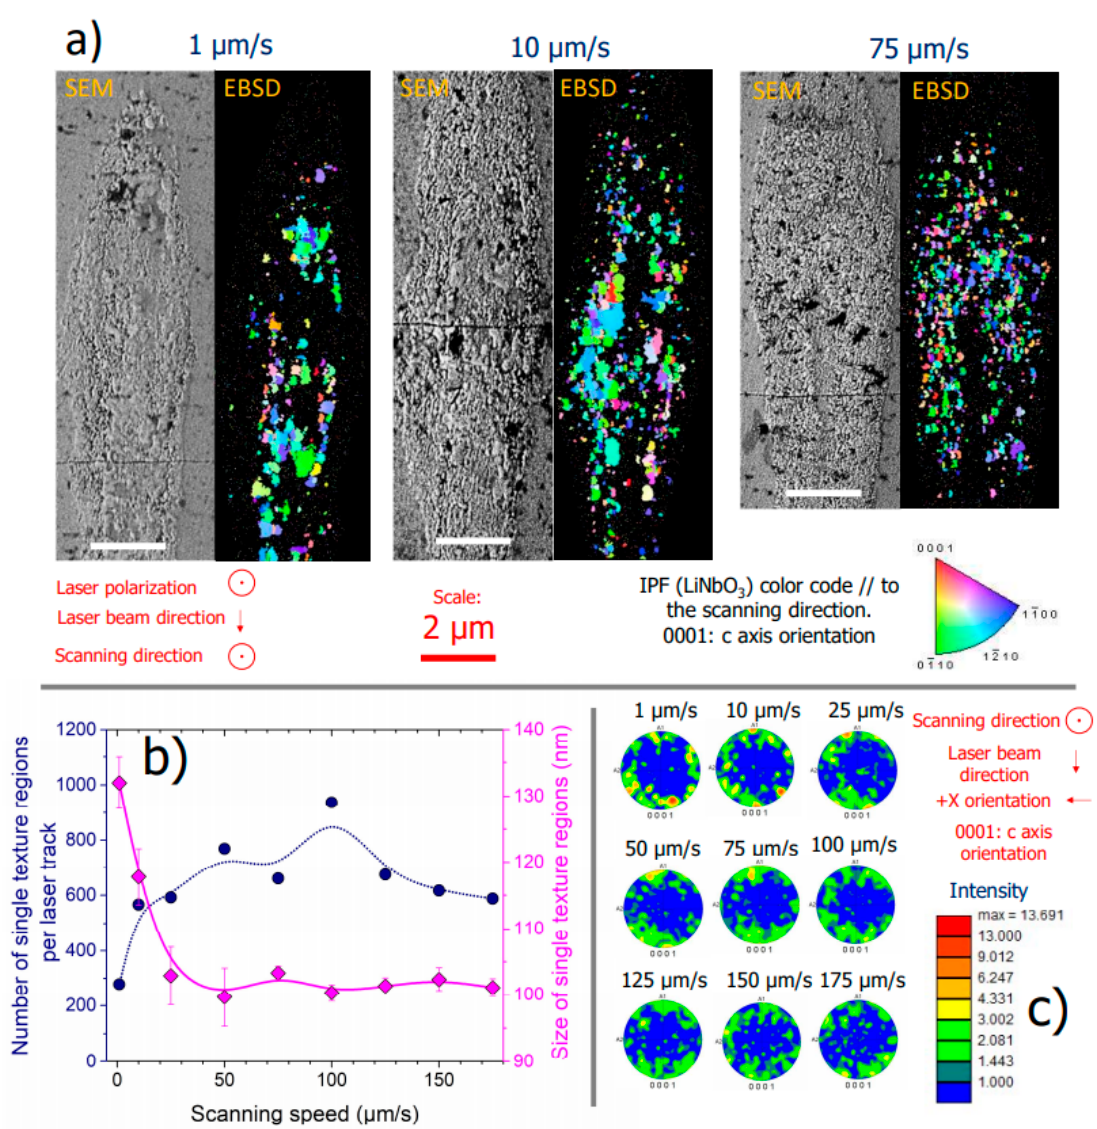
Figure 6. ( a ) Scanning electron microscope (SEM) micrographs and electron backscatter diffraction (EBSD) maps on the laser track cross-sections induced by fs-laser on LNSB glass sample and for different scanning speeds. Other (fixed) parameters are: pulse energy = 0.5 µJ; configuration = Yy (laser polarization // to the scanning direction); λ = 1030 nm; f = 200 kHz; NA = 0.6; pulse duration = 250 fs; focal depth: 240 µm (in air). ( b ) Number of single texture regions and their averaged diameter (assuming a spherical shape) as a function of scanning speeds, extracted from EBSD data, i.e., ( a ). ( c ) Pole figure of the LiNbO 3 c axis (labeled as 0001), also extracted from the EBSD data.